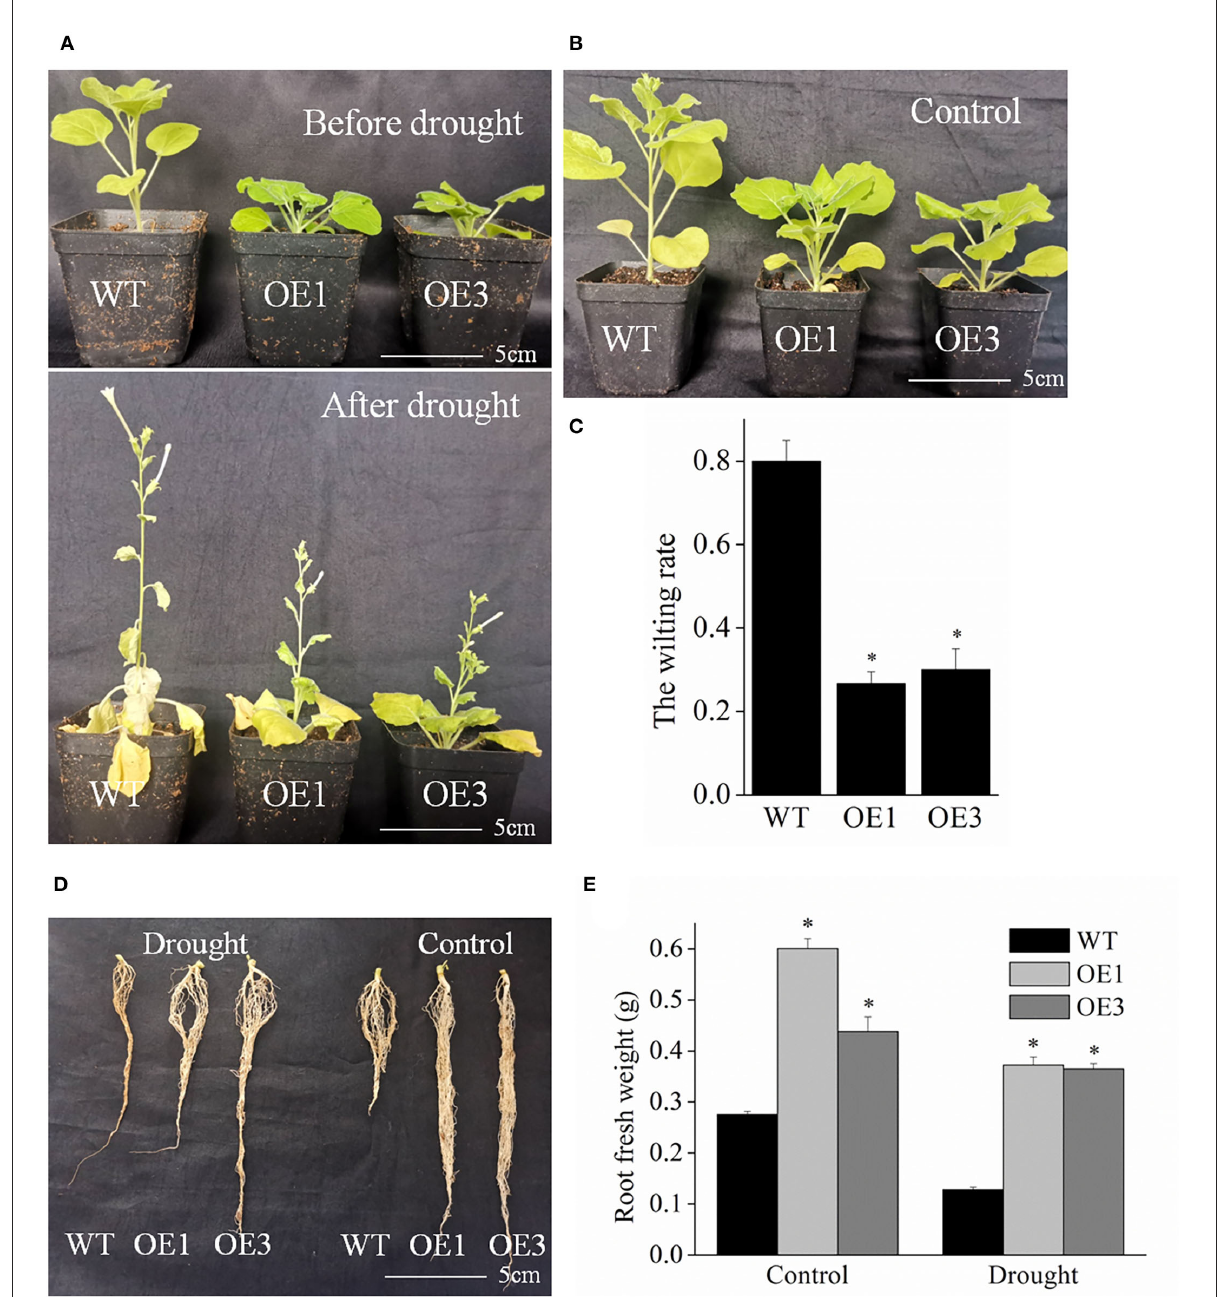
FIGURE6 The VyMYB24 gene improved the drought resistance in the tobacco transgenic lines. (A) Four-week-old transgenic and wild-type plants were treated with drought stress for 12 days with the normal as CK (B) . (C) The wilting rate of plants was measured, and the wilting rate was calculated based on the numbers of the plants with more than 50% leaves with wilting phenotype to the total plants. (D) The root phenotypes were observed before or after drought treatment, and the root fresh weight of plants was measured (E) . Bars represent mean ± SD. A significant difference from the WT was confirmed by a one-way ANOVA test, * p <